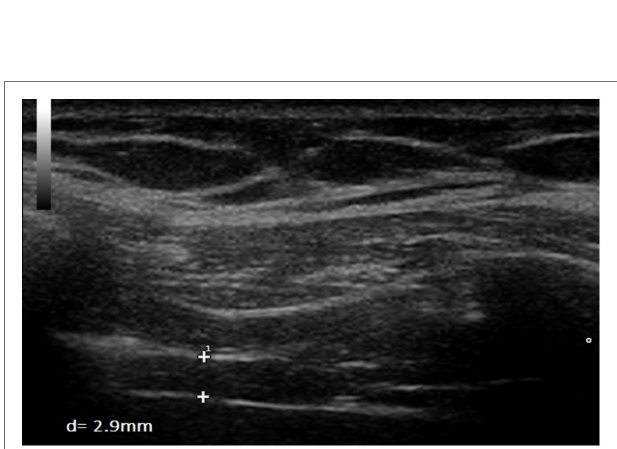
FIGURE 4 | Diaphragmatic excursion recorded in the same volunteer during breathing at tidal volume (0.6 l) with an inspiratory load of 30 cmH 2 O (2.9 cm).